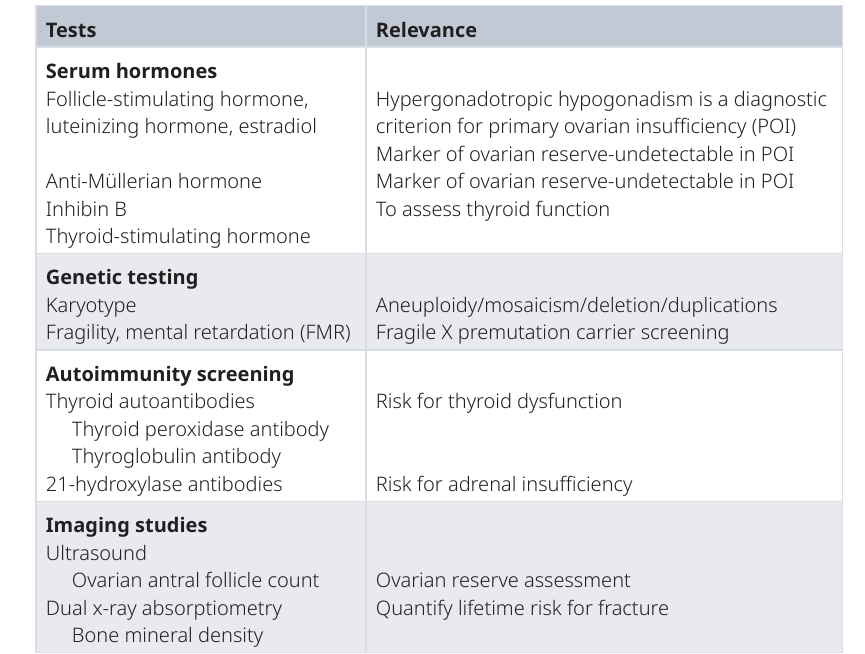
Table 2. Suggested workup for patients with primary ovarian insufficiency: elucidating the underlying etiology or identifying associated risks or